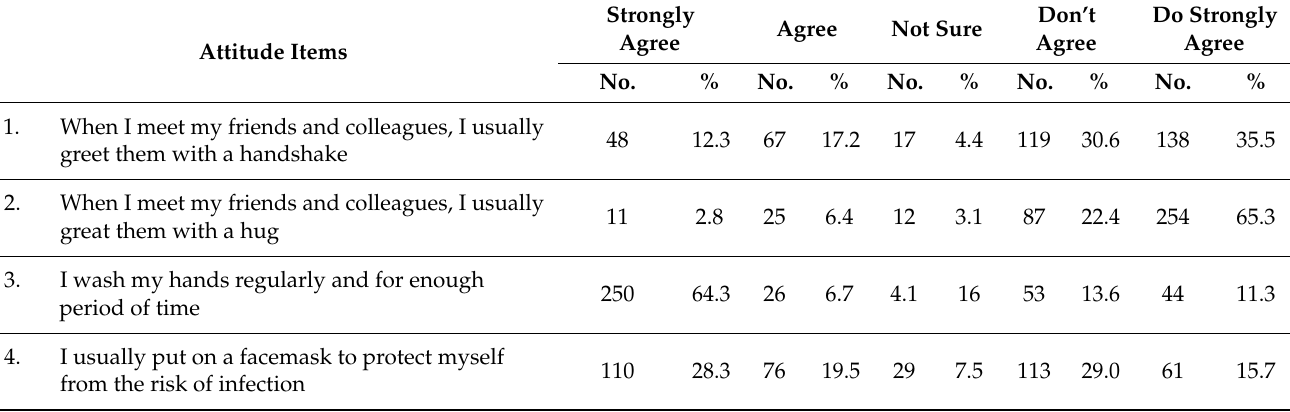
Table 3. Attitudes of the participants about